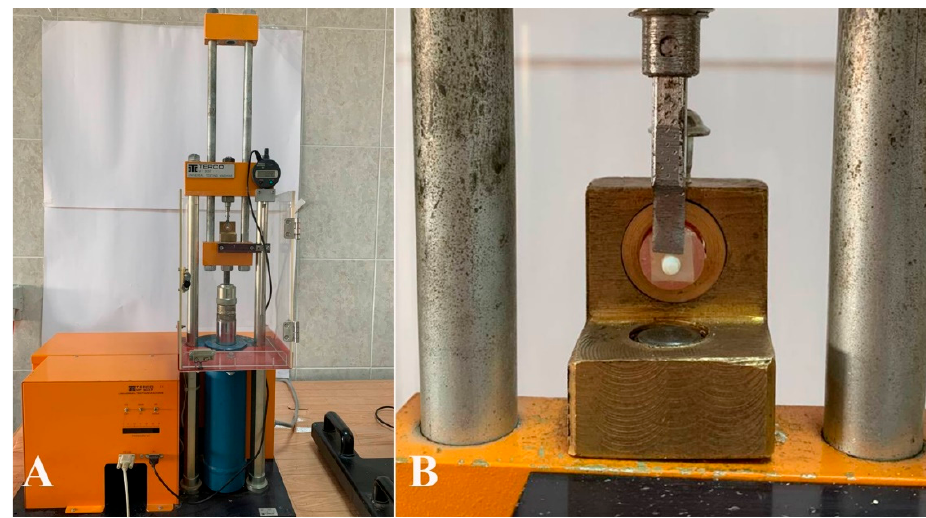
Figure 2. ( A ). Testing the SBS of the sample with the universal testing machine, ( B ). The position of the load application for SBS test.